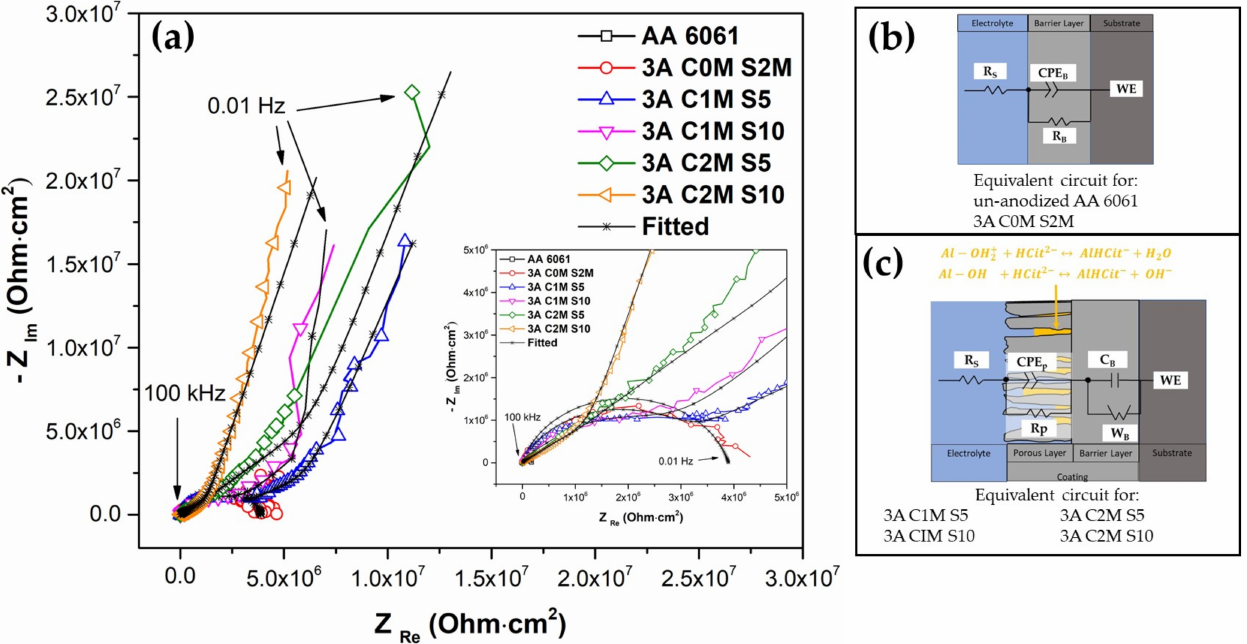
Figure 9. ( a ) Nyquist Diagrams in the Complex Plane to Non-Anodized and Anodized Samples a 3 A/dm 2 in NaCl Solution, ( b , c ) Equivalent